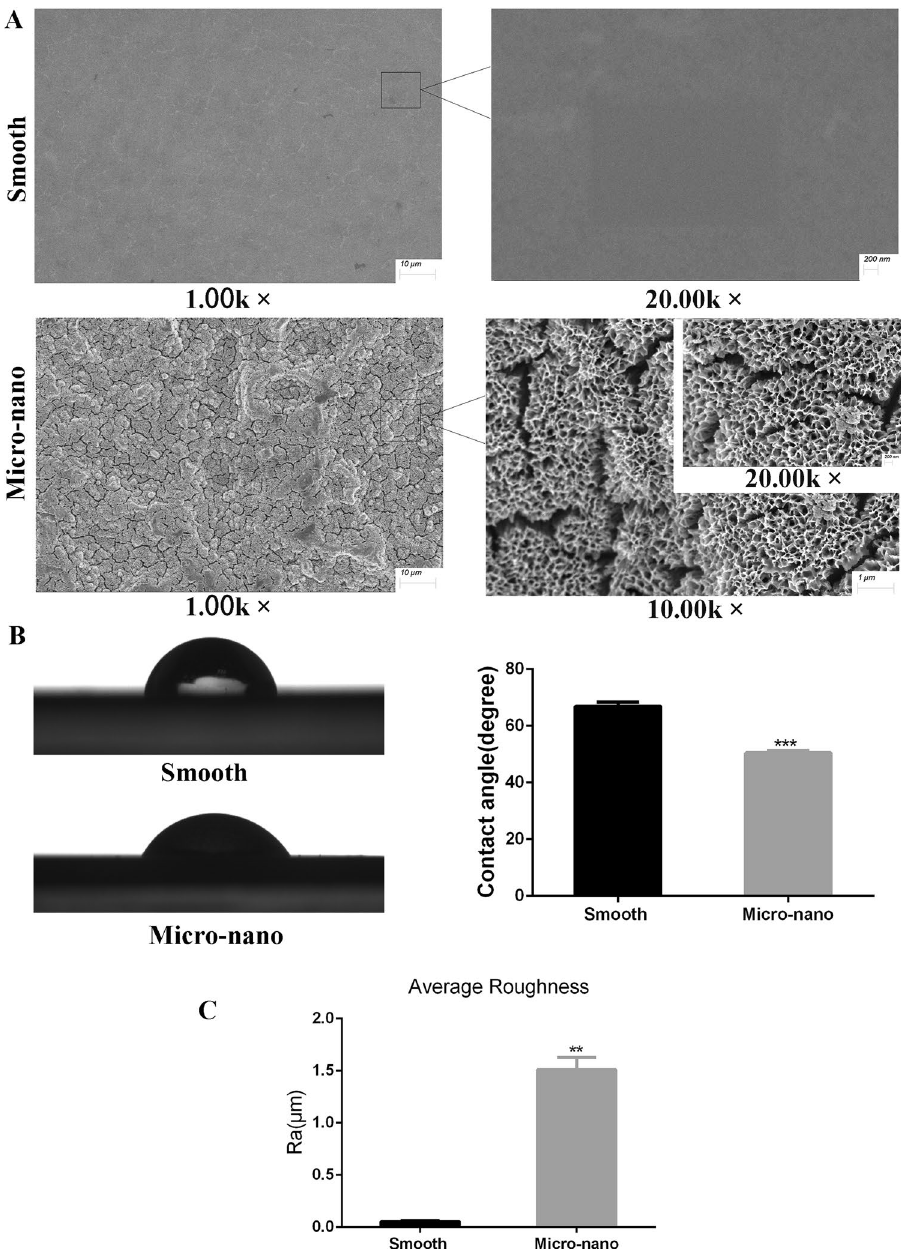
Figure 1. Characterization of material surface. ( A ) Scanning electron of surface topography. The smooth titanium disk was at ×1.00kand ×20.00k magnification; and the micro-nano titanium disk was at ×1.00k, ×10.00k and ×20.00k magnification. ( B ) Contact angle test. ( C ) Roughness detection ( smooth smooth titanium disk, Micro-nano micro-nano topography titanium disk. * p < 0.05; ** p < 0.01; *** p <